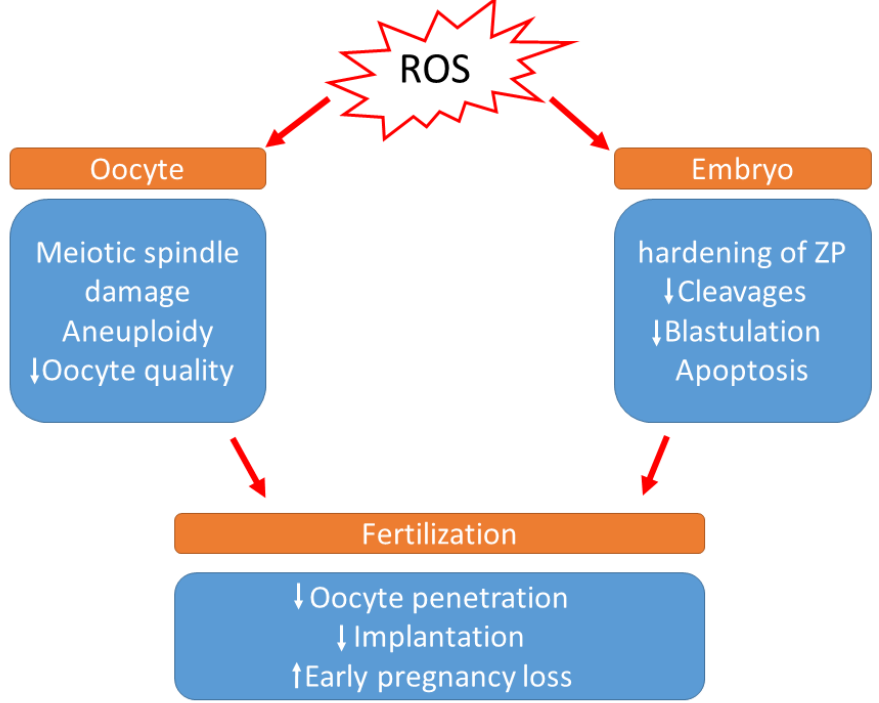
Figure 2. Effects of increased levels of reactive oxygen species during IVF. (ROS: Reactive oxygen species, ZP: zona pellucida).